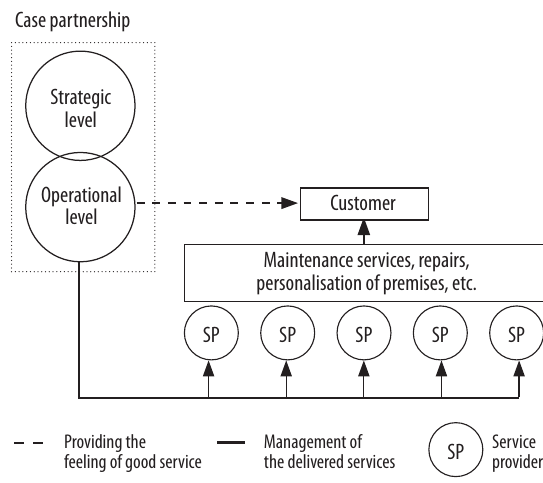
Fig. 2. The value delivering